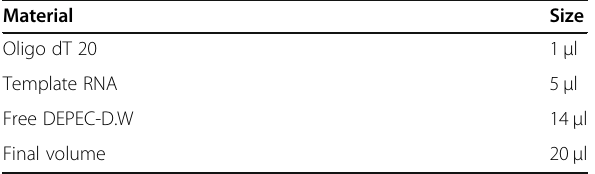
Table 1 The reaction components of cDNA synthesis